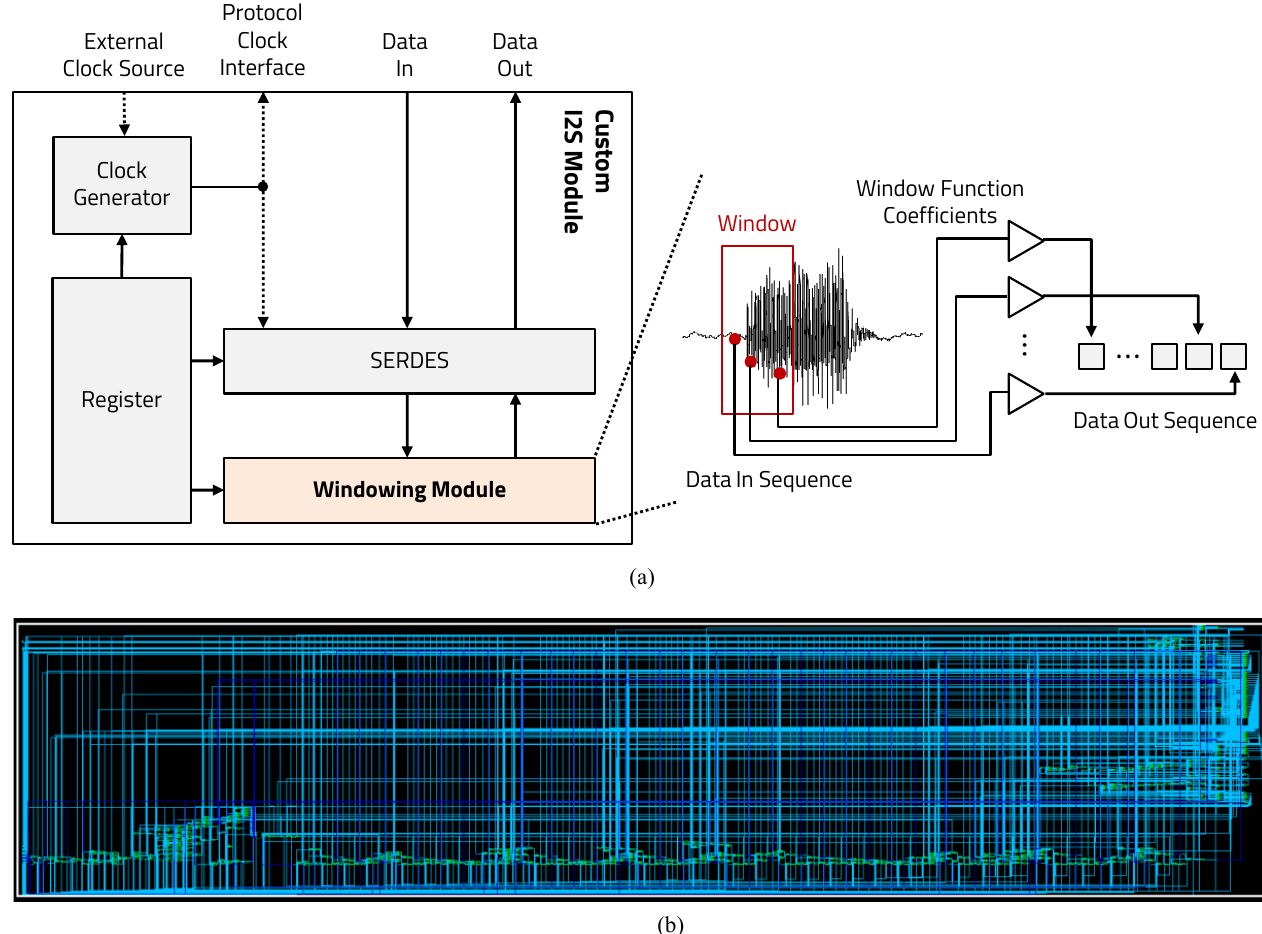
Figure 5. Proposed architecture of the custom I 2 S module. ( a ) I 2 S data path ( b ) synthesized schematics of I 2 S